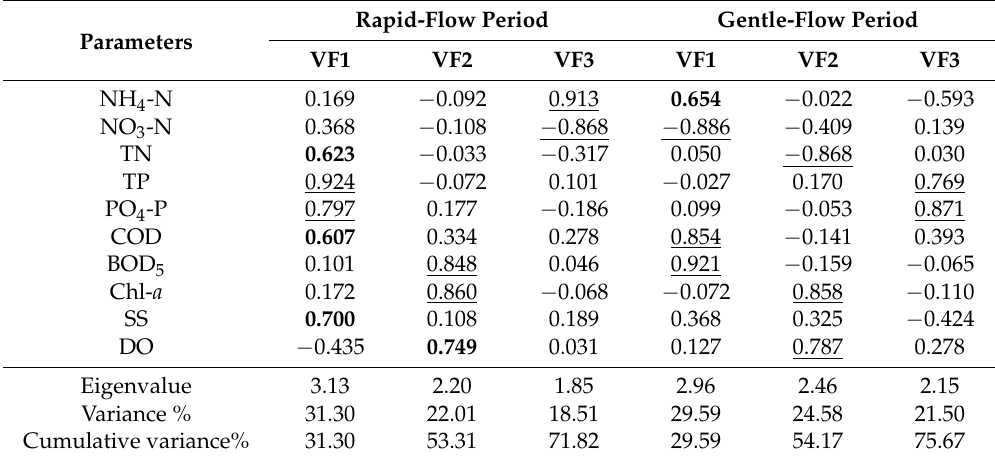
Table 7. Factor loadings value and explained variance of water quality parameters in two periods.